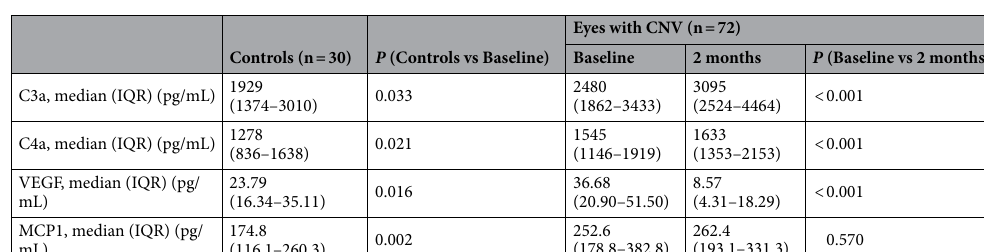
Controls (n = 30) P (Controls vs